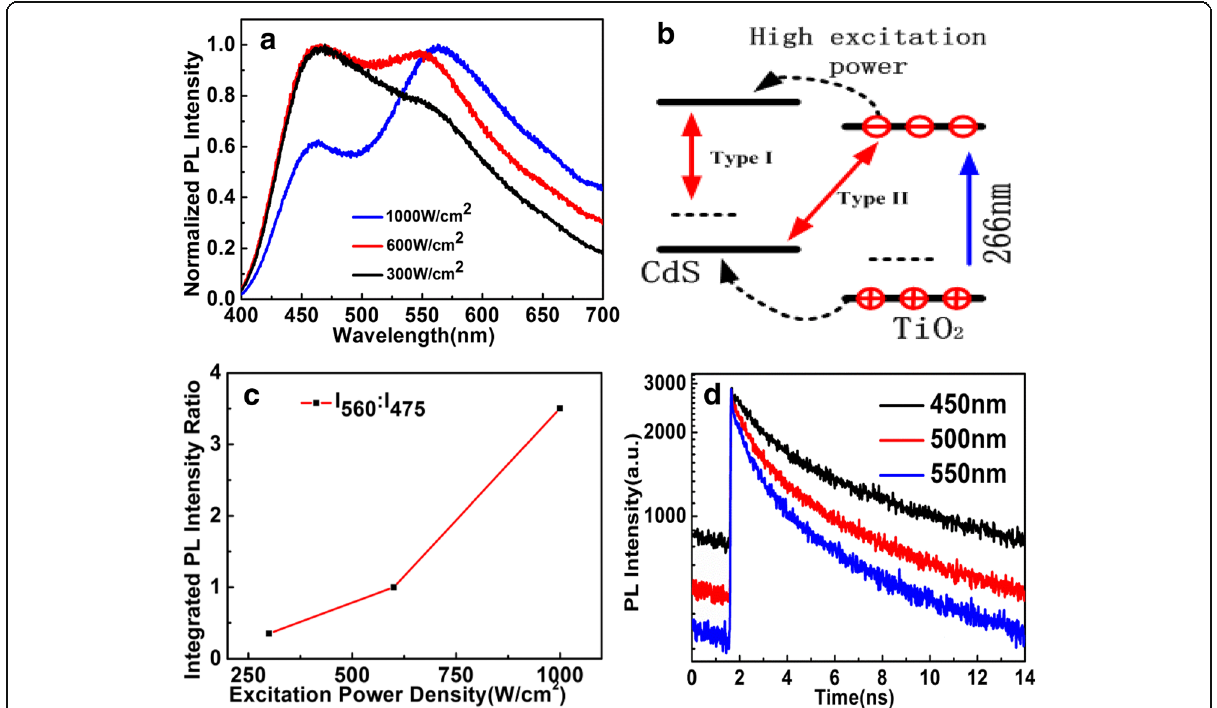
Fig. 4 a Excitation power dependence of PL spectra. b Electron transfer from conduction band of Ti 0.91 O 2 to CdS with high-power excitation. c The integrated PL intensity ratio between central wavelength 560 and 475 nm. d The time-resolved PL measurements for 450, 500, and 550 nm with 266 nm excitation